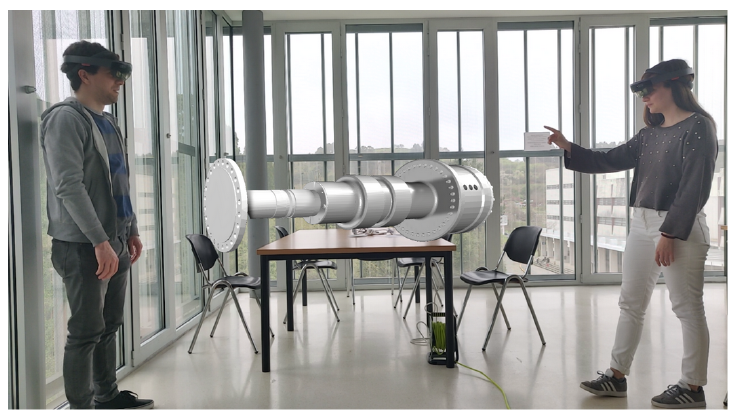
Figure 11. Developers testing the AR application at the university